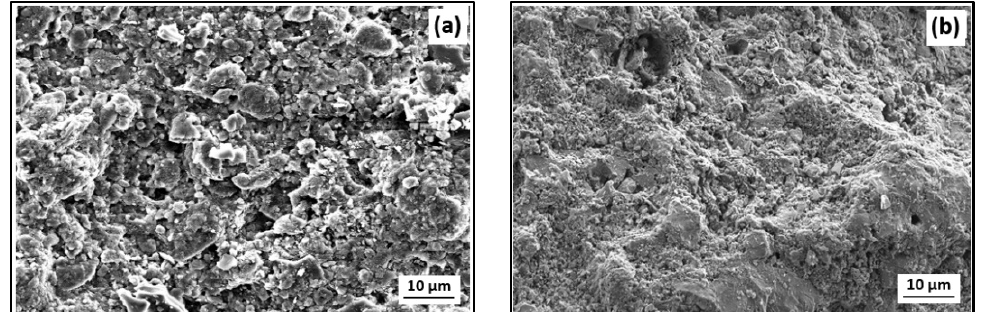
Figure 7. SEM micrographs of composite membrane surface. Kaolin/Sand sintered at 900 °C ( a ) and Kaolin/Zeolite sintered at 850 °C ( b ). Adapted from [87,88].